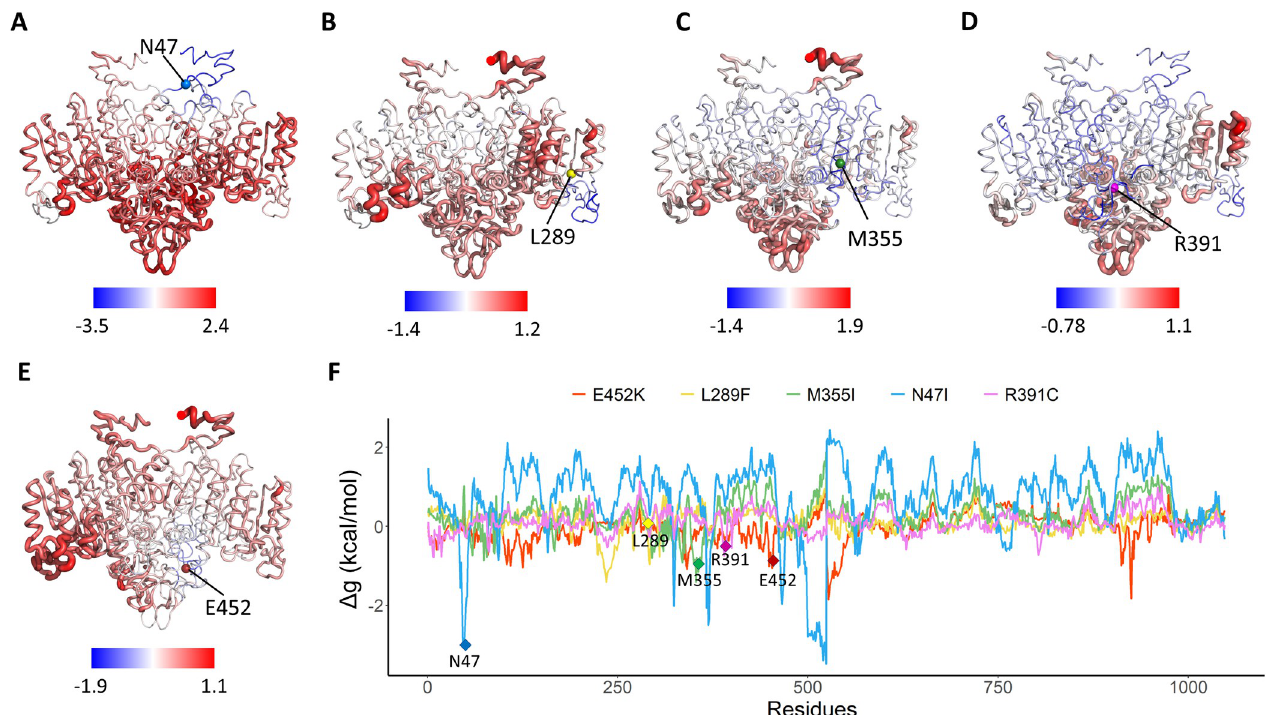
Fig 9. Allosteric effects of three studied severe mutations (N47I, L289F and M355I) and two predicted severe mutations (R391C and E452K) calculated by AlloSigMA. Cartoon structures of the TNSALP protein colored according to their free energy values obtained for the cases of (A) N47I, (B) L289F, (C) M355I, (D) R391C and (E) E452K, while blue color indicates negative allosteric free energy and red color indicates positive modulation. (F) Their free energy profiles are illustrated graphically with the residue index (chain A : 1–524; chain B : 525–1048) on the x -axis and Δ g value on the y -axis. Blue, yellow, green, pink and red profiles represent the results for N47I, L289F, M355I, R391C and E452K, respectively.